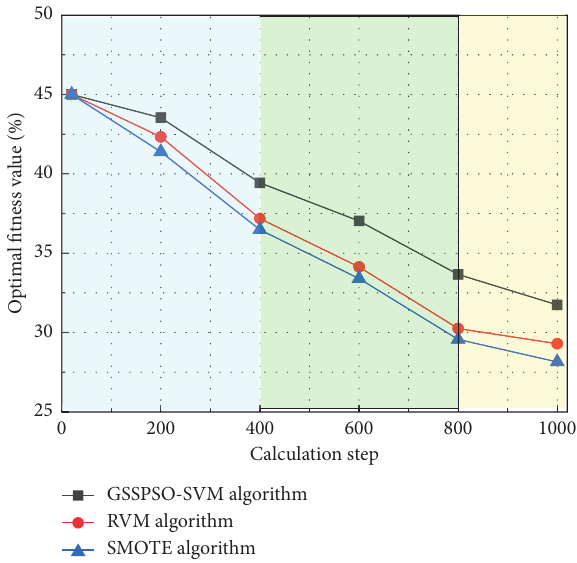
Figure 4: Performance comparison of different